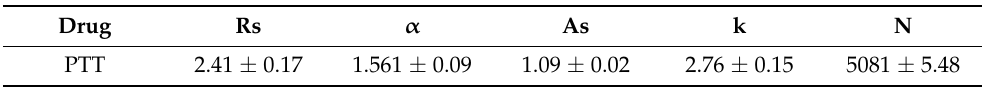
Table 3. Optimized chromatographic peak parameters to determine CCM for the greener HPLC methodology (mean ± SD, n = 3).